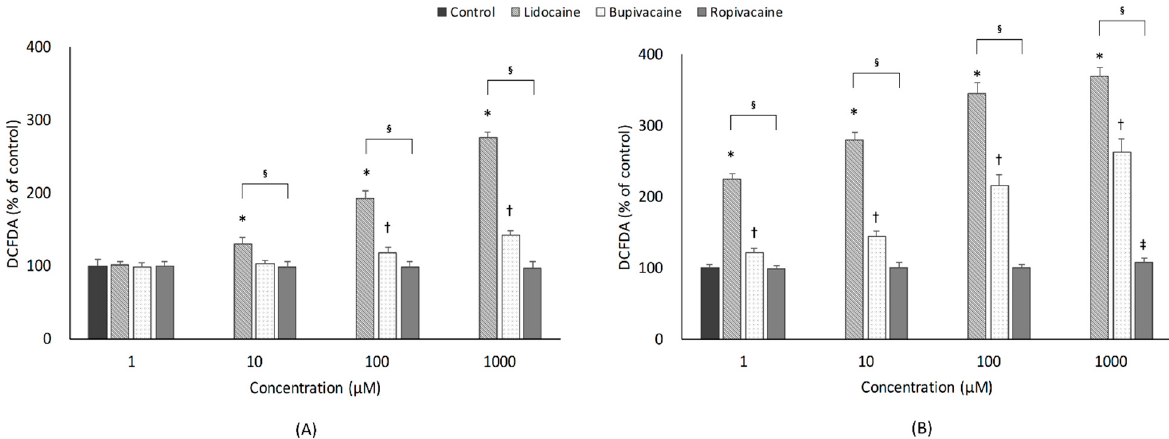
Figure 3. Effects of local anesthetics on reactive oxygen species, which were assessed using the 2 ′ ,7 ′ -dichlorofluorescein diacetate (DCFDA) assay. Developing motor neurons were exposed to the indicated concentrations (1, 10, 100, or 1000 µM) of local anesthetics for ( A ) 1 h or ( B ) 24 h. All data are expressed as means ± standard deviations. Differences between the results were evaluated by two-way ANOVA, followed by Dunnett’s test for multiple comparisons. * p < 0.05, lidocaine vs. control group. † p < 0.05, bupivacaine vs. control group. ‡ p < 0.05, ropivacaine vs. control group. § p < 0.05, differences among the 3 groups by ANOVA.